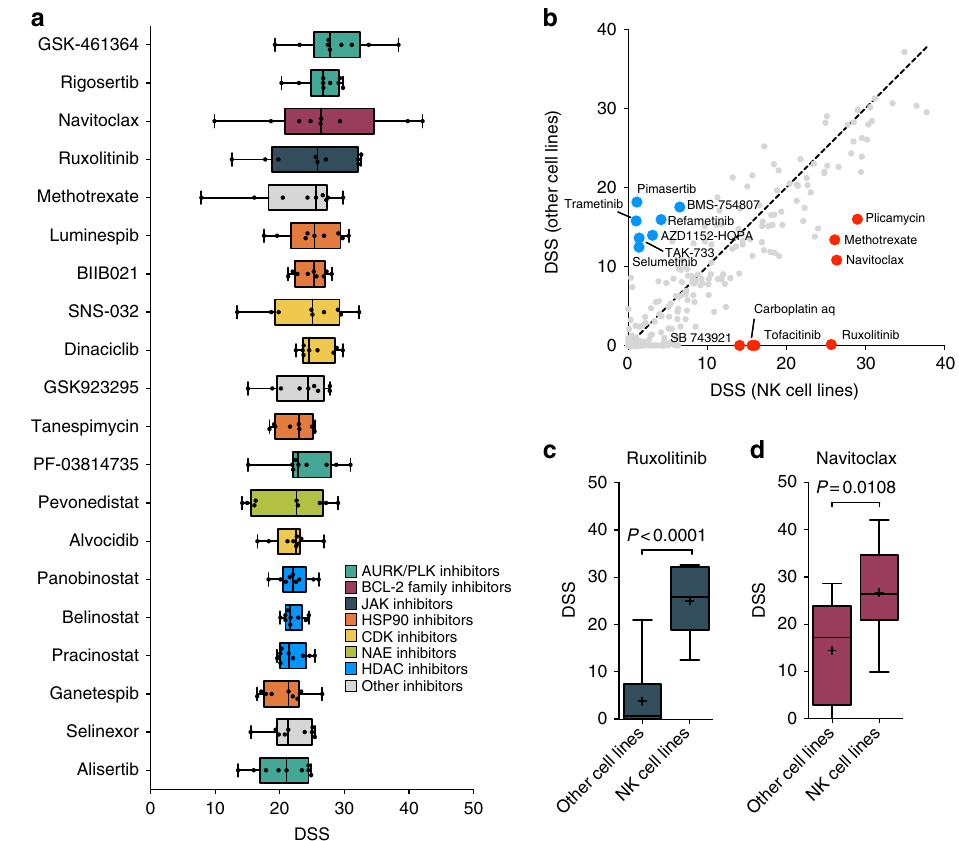
Fig. 3 Effective targeted agents identi fi ed by drug sensitivity pro fi ling in NK cell lines. a 25 most effective targeted compounds across NK cell lines ( n = 9). Compounds are ordered by median drug sensitivity score (DSS). Higher DSS indicates higher sensitivity to a compound. Drugs annotated as conventional chemotherapeutics (Supplementary Data 7) and broadly active cytotoxic compounds (CUDC-907, YM155, daporinad, KX2-391, UCN-01, ONX-0914) are excluded. b Scatter plot comparing median DSS of NK cell lines ( n = 9) to median DSS of other cell lines ( n = 29), including 23 acute myeloid leukemia, three chronic myeloid leukemia, and three T-cell acute lymphoblastic leukemia cell lines, for 261 drugs. Drugs with median DSS > 10 units higher and lower in NK cells compared to other cells are labeled red and blue, respectively. c – d Comparison of DSS to ruxolitinib ( c ) and navitoclax ( d ) between NK cell lines and other cell lines. Lines in boxes indicate median, plus signs indicate mean, error bars indicate range and boxes represent interquartile ranges. P values were calculated using the Mann – Whitney U